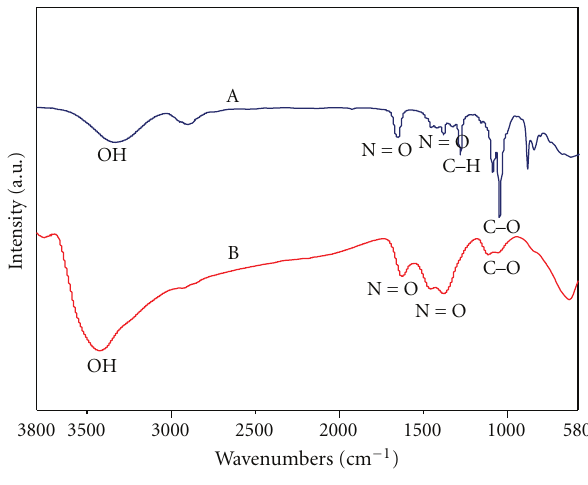
Figure 3: IR spectra recorded at (A) the collodion membrane and (B) the as-synthesized Pt-on-NiCo